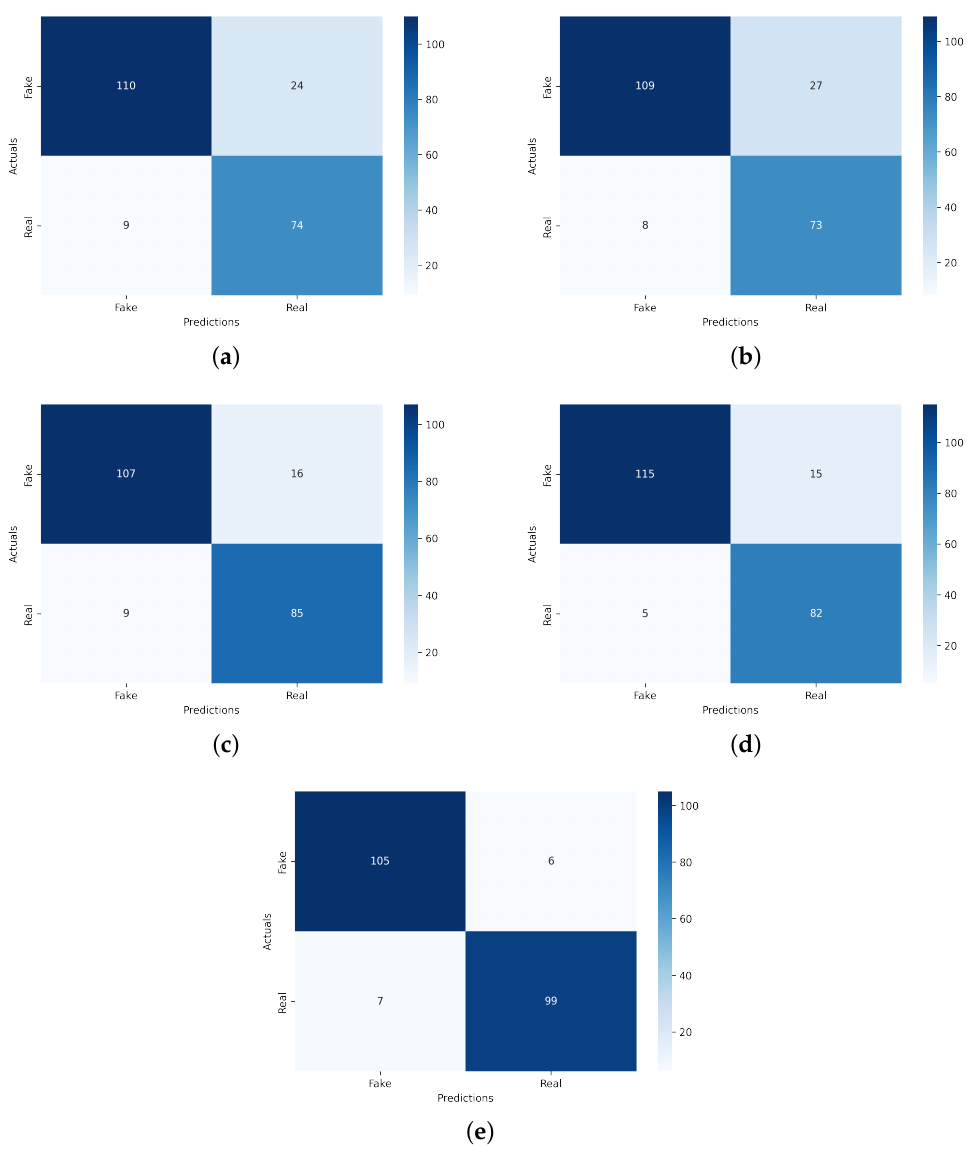
Figure 6. The bar chart-based loss score comparative analysis of employed neural network techniques.